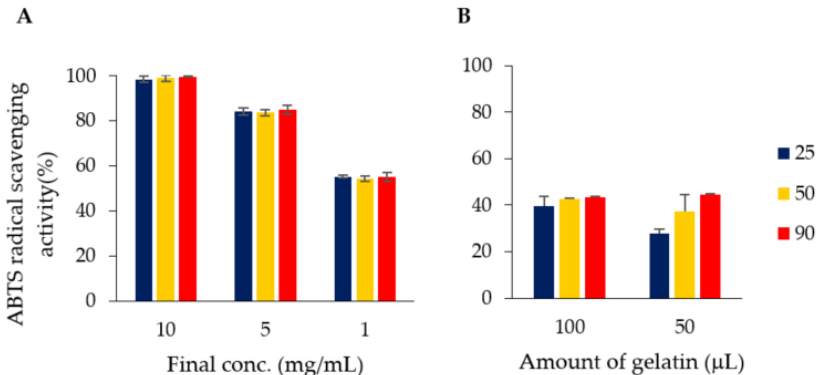
Figure 7. ABTS radical scavenging capacity of green tea extract solution ( A ) and green tea extract– adsorbed gelatin ( B ). The green tea extract ( A ) was measured at final concentrations of 10, 5 and 1 μ g/mL. For gelatin ( B ), measurements were performed with 100 and 50 μ L of gelatin. RT: Unheated green tea extract or green tea extract–adsorbed gelatin; 50 or 90 °C: Green tea extract or green tea extract–adsorbed gelatin pre-treated at the respective temperature (Blue: 25 °C; Yellow: 50 °C; Red: 90 °C).